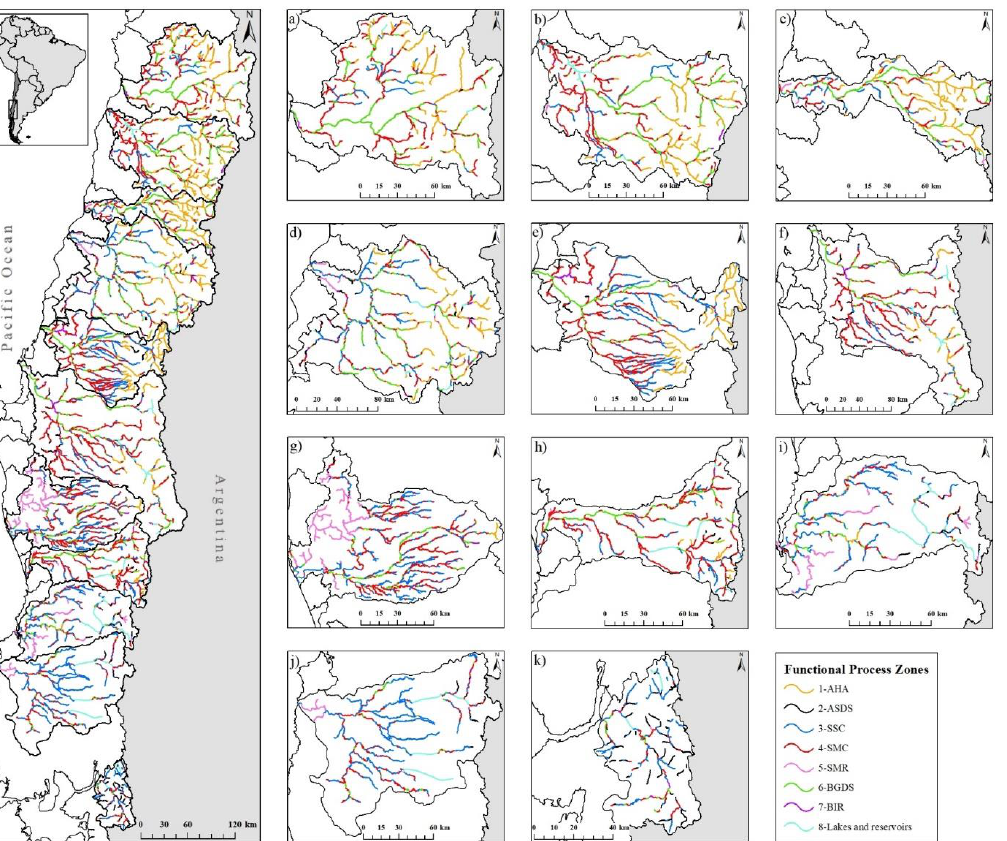
Figure 3. Position of the identified FPZs in each of the eleven river networks. ( a ) Maipo; ( b ) Rapel; ( c ) Mataquito; ( d ) Maule; ( e ) Itata; ( f ) Biobío; ( g ) Imperial; ( h ) Toltén; (i) Valdivia; ( j ) Bueno; ( k ) Puelo. Singular or rare sections are not drawn.